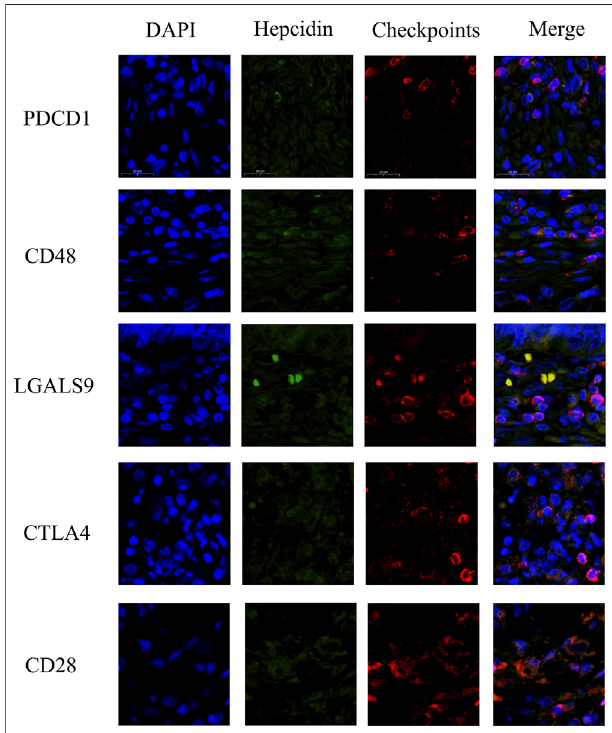
FIGURE 8 | Immuno fl uorescence staining results showing the co- expression and co-localization between hepcidin and selected immune checkpoints in formalin- fi xed paraf fi n-embedded kidney renal clear cell carcinoma (KIRC) tissue. The veri fi ed checkpoint molecules were as follows: CD28, CD48, LGALS9, CTLA4, and PDCD1. These checkpoint molecules were con fi rmed as the common associated immune checkpoint molecules in male genitourinary system